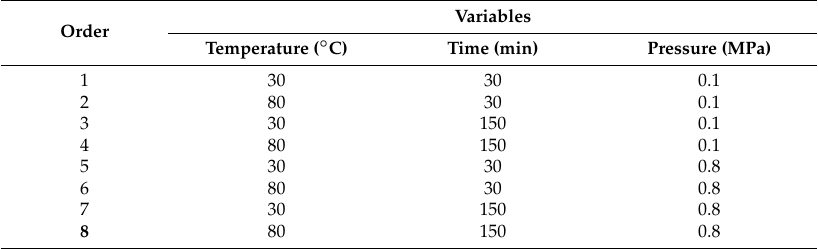
Table 2. The 2 3 full factorial experiment design for glycerol